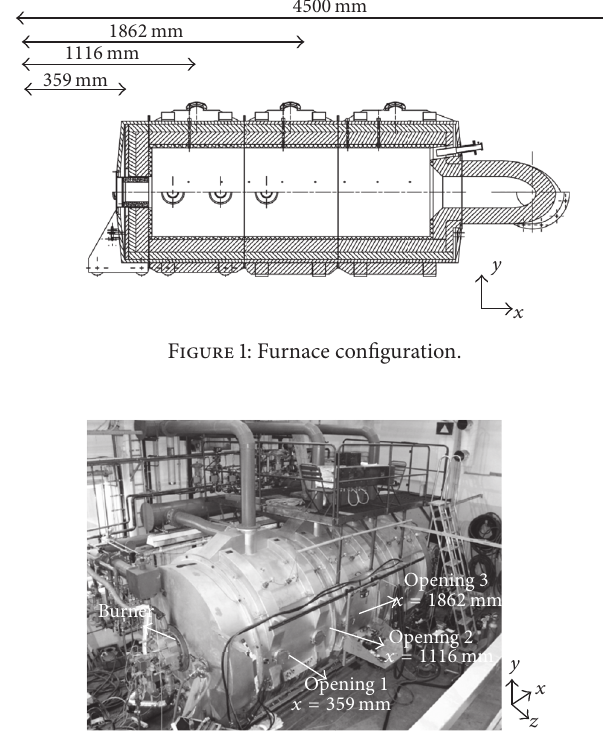
Figure 2: A photo of the furnace including the three